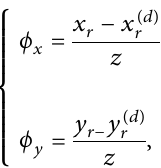
Figure 4: Optical path difference (wavefront error) of the designed beam